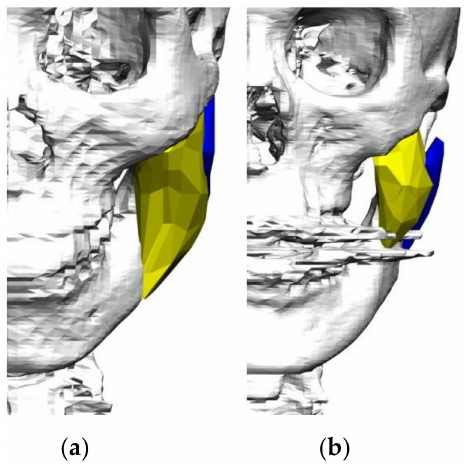
Figure 2. Volume of the masseter muscle. Yellow represents the superficial part of the masseter muscle and blue represents the deep part. Masseter muscle volumes of the ( a ) normal group and ( b ) prognathic group. (Maya, version 2018,